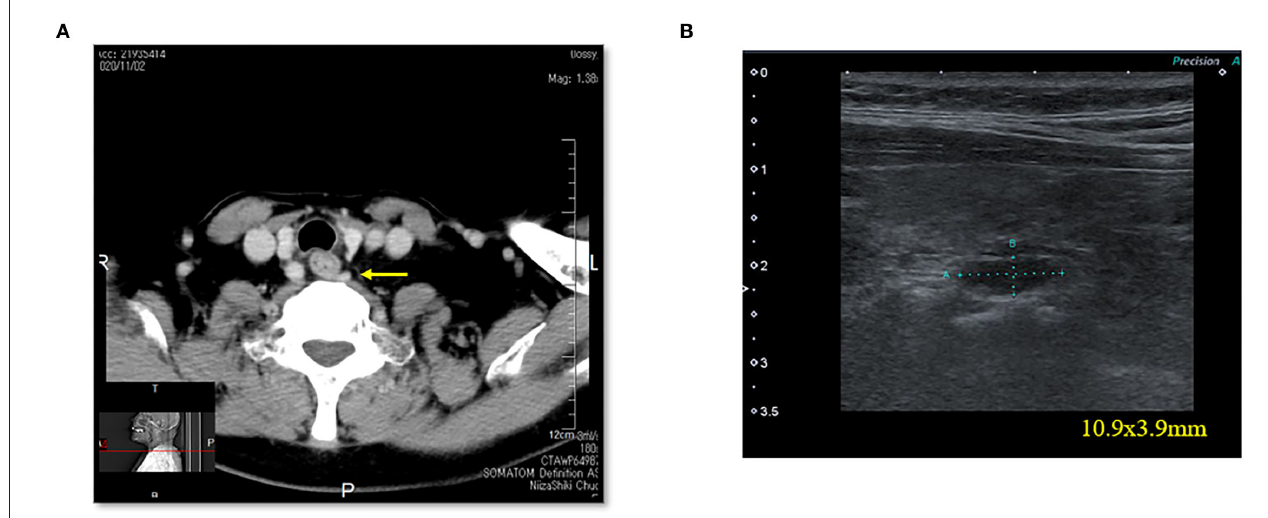
FIGURE 5 | Case 6. (A) Thoracic enhanced CT scan showing a mass (EPA: yellow arrow) near the cervical esophagus. (B) Cervical neck ultrasound showing a mass (10.9 × 3.9mm [EPA]) near the cervical esophagus.